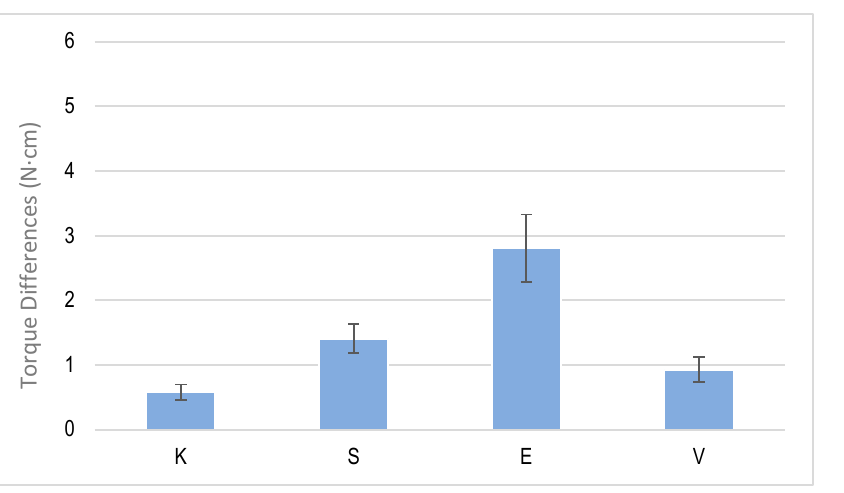
Figure 5. Configuration of the experiment in an electromechanical test machine that applied loads from 20 N to 200 N and the two high-resolution cameras that determined the micromovements.